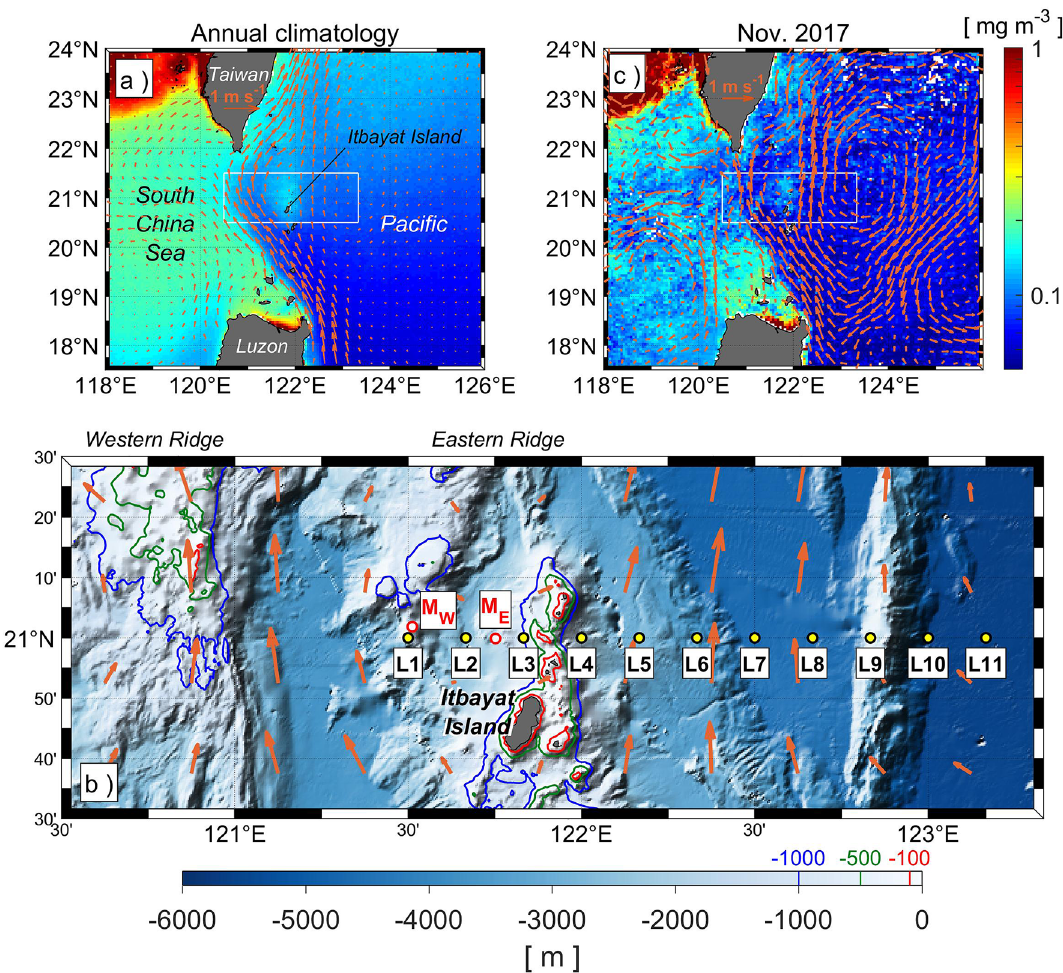
Figure 1. Map of surface chlorophyll a concentration, geostrophic currents, and bathymetry around the Luzon Strait. ( a ) Annual climatology of MODIS-Aqua chlorophyll a (color shading) and CMEMS absolute geostrophic velocity (arrows) during 2004–2018. The location of the experiment site is indicated by the white rectangle. ( b ) Bathymetric map with microstructure stations L1–L11. Red circles represent mooring stations; M W and M E are where upward-looking 75-kHz Long Ranger ADCPs were moored. Red, green, and blue lines in the bathymetric map show the 100, 500, and 1000-m isobaths, respectively. Arrows represent absolute geostrophic velocity during the experiment period. ( c ) Weekly averaged surface chlorophyll a and absolute geostrophic velocity, as in ( a ) but for November 2017. Color scale for chlorophyll a is the same in ( a ) and ( c